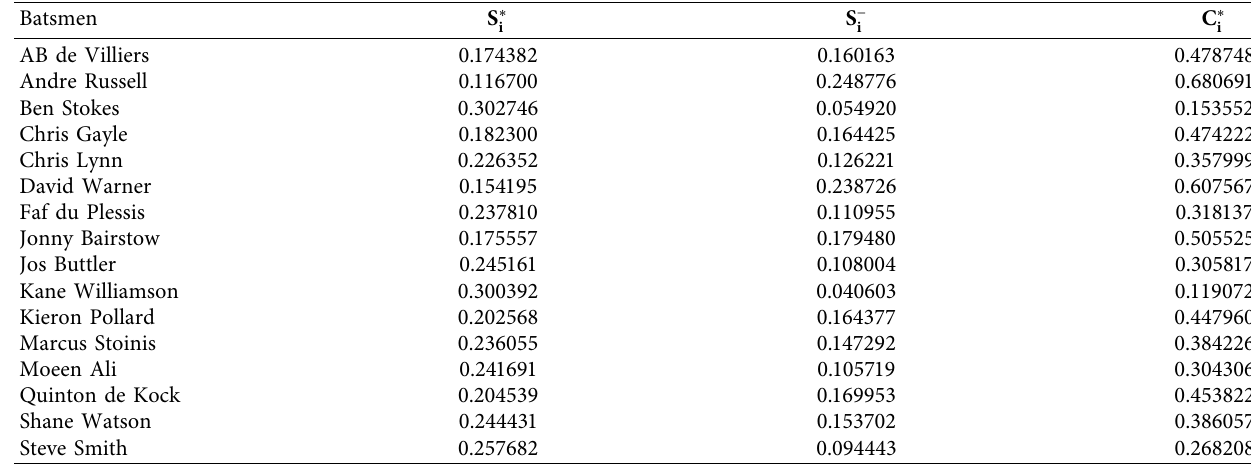
Table 7: Distance values for batsmen.